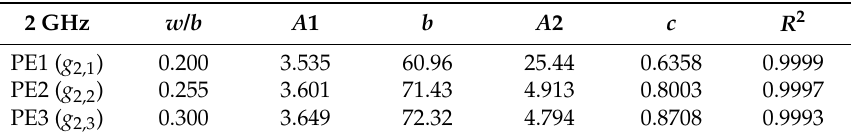
Table 4. Regression coefficients and goodness of fits for Equation (4).